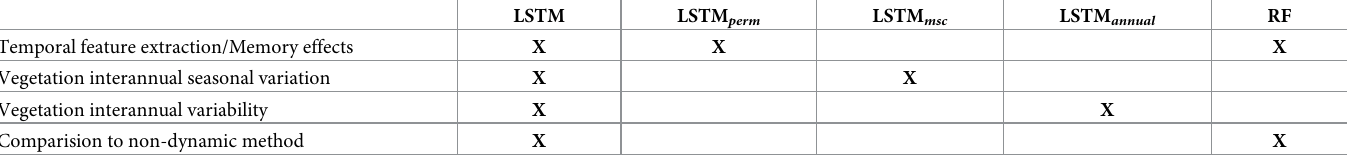
Table 1. Design of the factorial experiment. X means that the variant was used to study the respective topic of each row. LSTM = LSTM model using the full depth of the Landsat time series and climate data; LSTM perm = LSTM model but the temporal patterns of both the predictive and the target variables were randomly permuted while instantaneous relationships between predictive and target variables were kept; LSTM = LSTM model but the Landsat time series for each band were replaced by their msc mean seasonal cycle, while using the actual values of air temperature (T air ), precipitation (P), global radiation (Rg), and vapor pressure deficit (VPD); LSTM annual = LSTM model but the Landsat time series for each band were replaced by their annual mean, while using the actual values of T , P, Rg, and VPD, RF = Random Forest model air using the actual values of the Landsat time series and climate